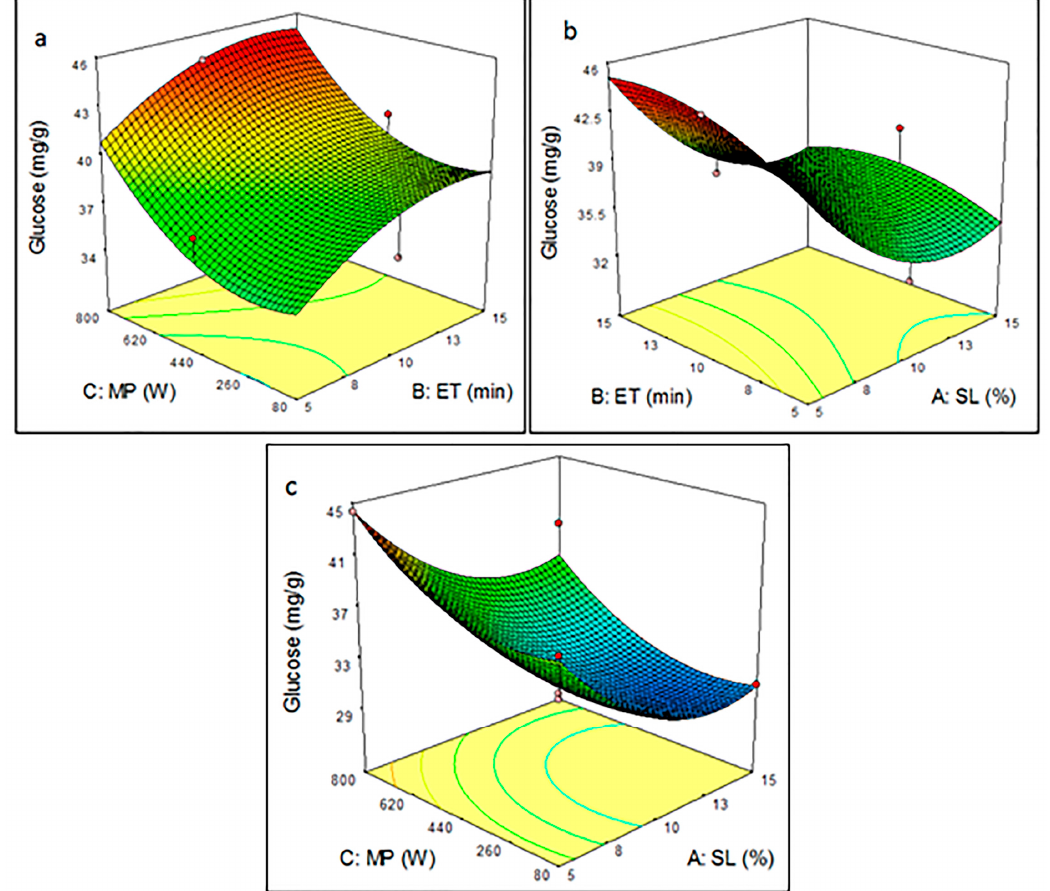
Figure 3. The effect of pretreatment parameters of MSH pretreatment on the glucose yield ( a ) with MP and ET at a constant SL, ( b ) with ET and SL at a constant MP, and ( c ) with MP and SL at a constant ET.